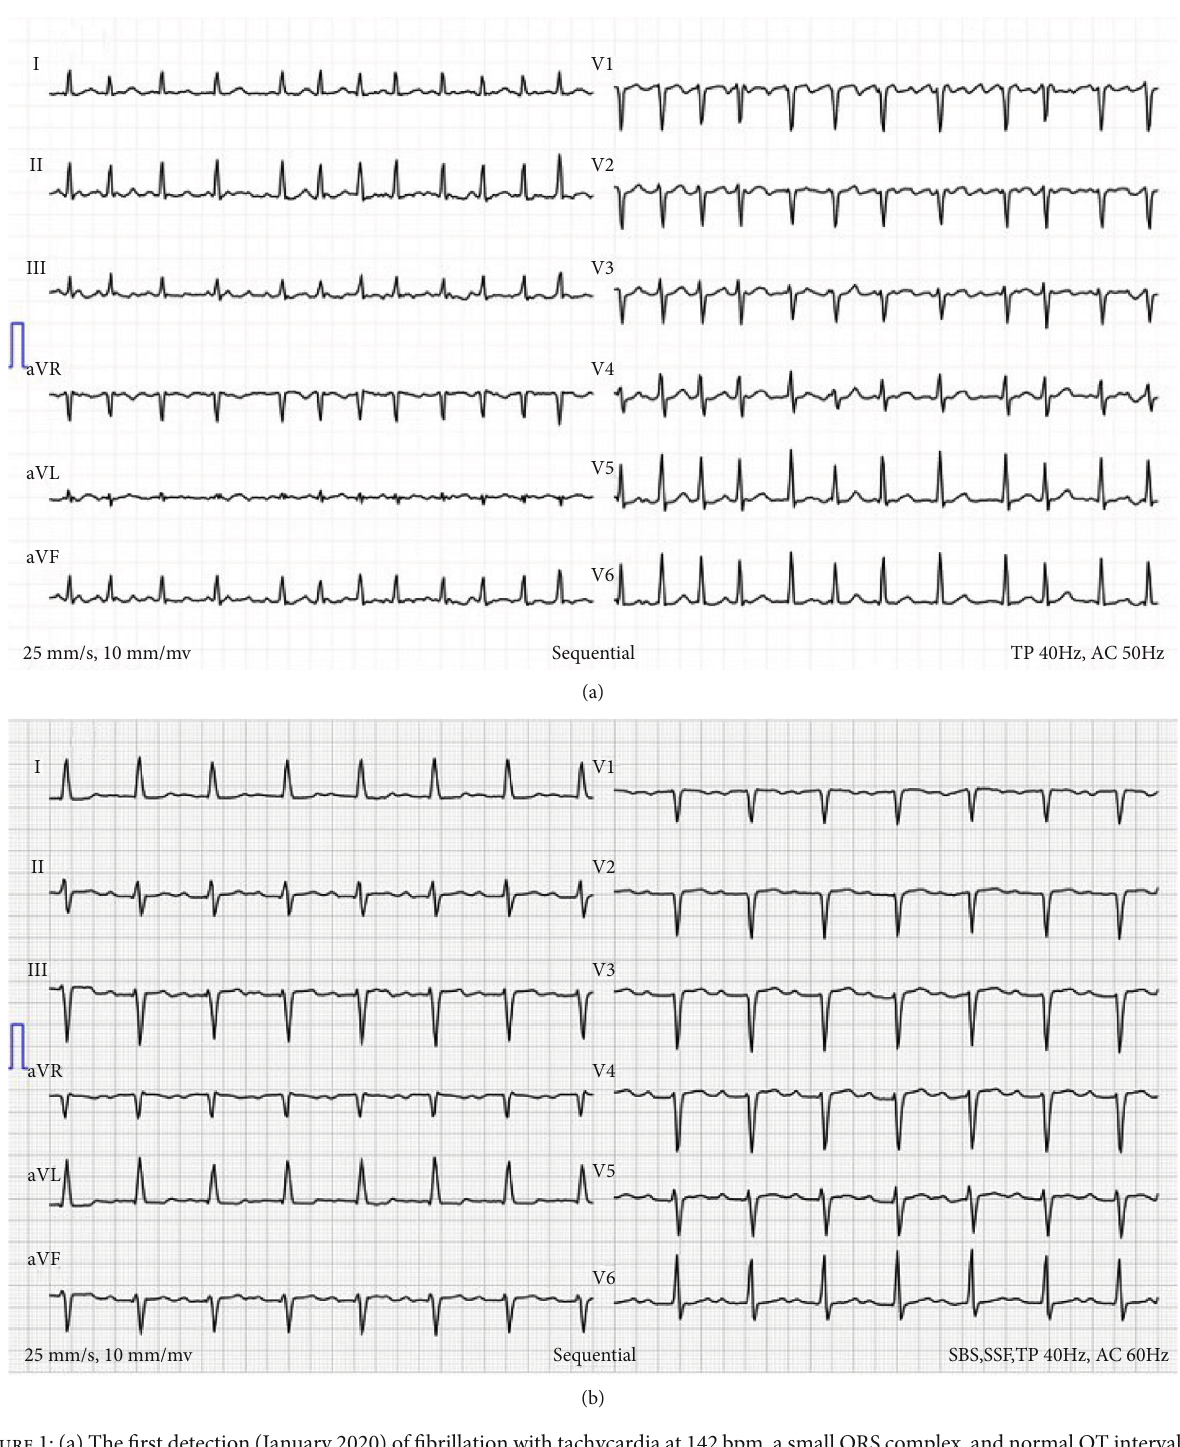
Figure 1: (a) The fi rst detection (January 2020) of fi brillation with tachycardia at 142 bpm, a small QRS complex, and normal QT interval. (b) At discharge, the patient showed a sinus rhythm with an AV block I ° ( PQ = 264ms ), 88bpm, small QRS complex, and normal QT